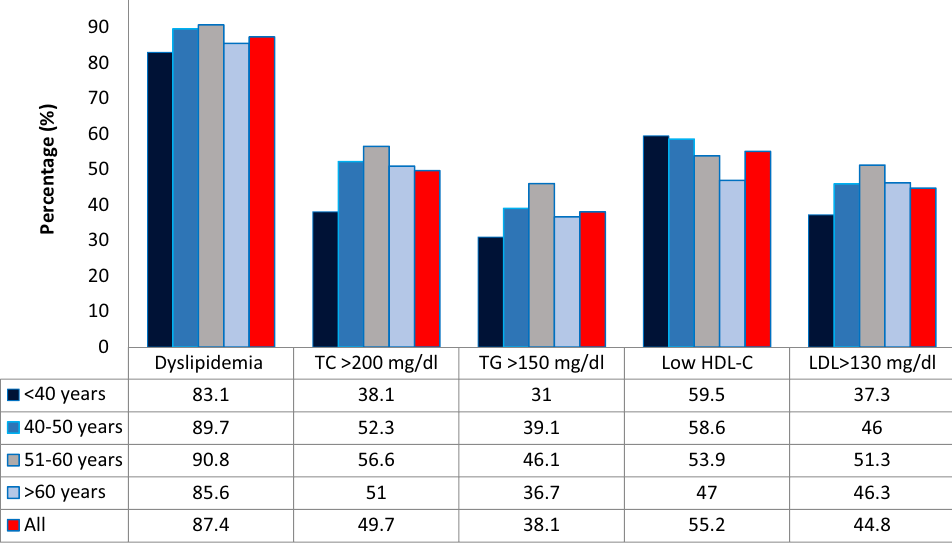
Figure 2. Prevalence of dyslipidemia within specific age strata.